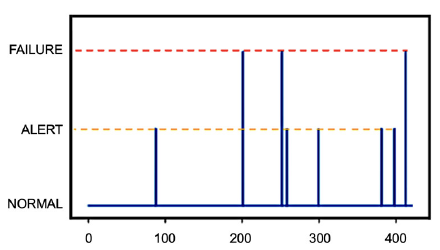
Figure 14. Time series of Press classification results.